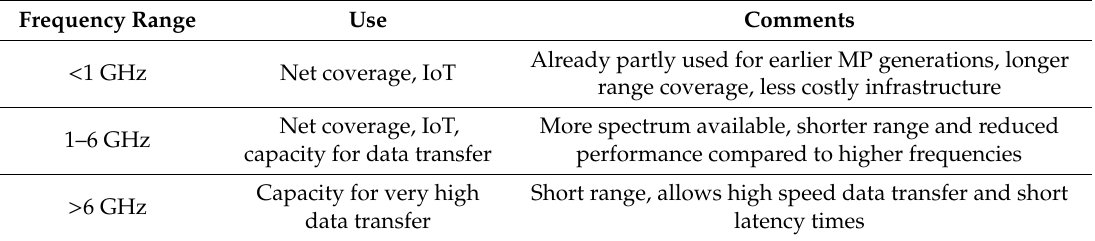
Table 1. Subdivision of the 5G frequency